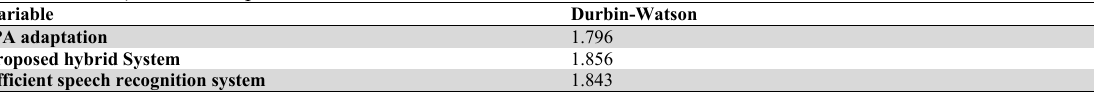
(Durbin-Watson) test of Independent Variables